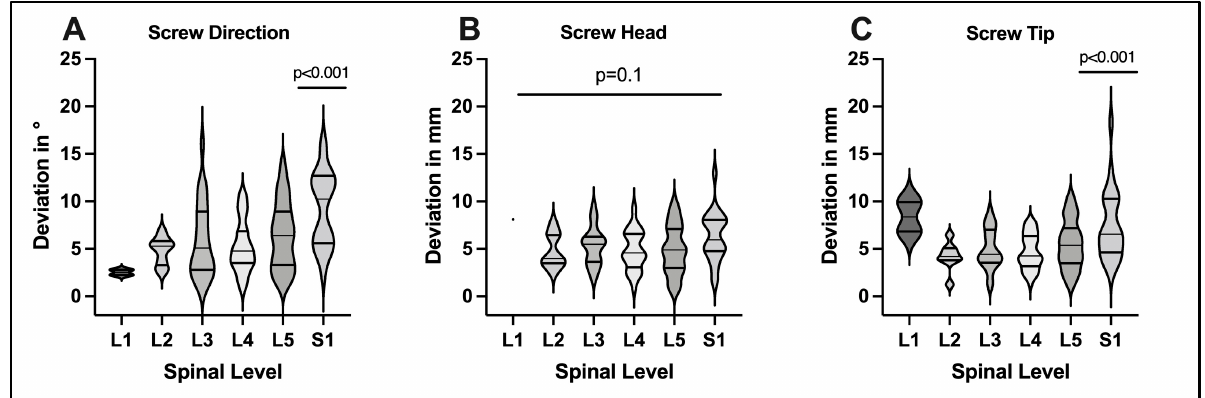
Figure 5. Evaluation of screw accuracy for screw direction ( A ), screw head ( B ) and screw tip ( C ) in relation to the spinal level treated. While deviation of final screw position and preplanned trajectory were comparable across spinal levels for screw head ( B ) ( p = 0.1), significantly increased deviations were observed at the S1 level for screw direction ( A ) ( p < 0.001) and screw tip ( C ) ( p < 0.001), respec- tively. L1 was excluded from this statistical analysis due to paucity of data ( n = 2 screws).